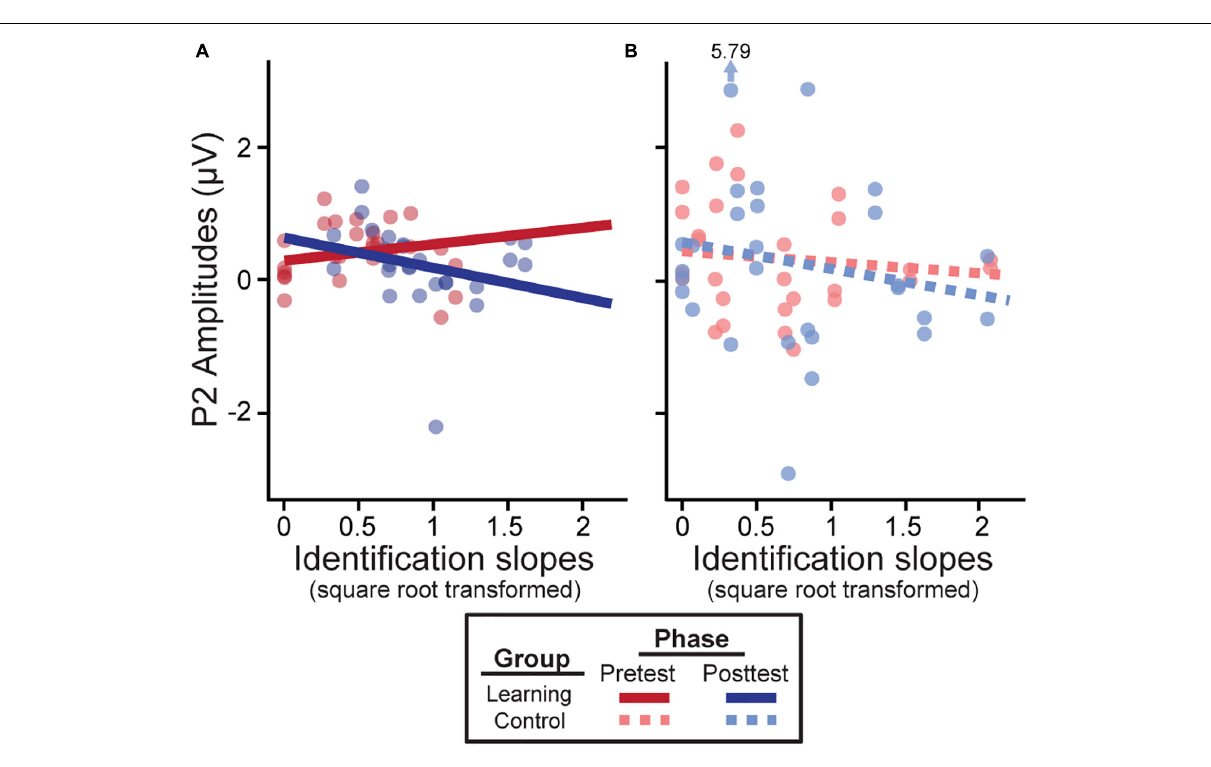
FIGURE 4 | Neural amplitudes scale with behavioral outcomes in the learning group (A) but not the control group (B) . Better posttest categorization (i.e., steeper identification slopes) is associated with a decrease in P2 amplitudes. Identification slopes were square-root transformed for statistical analysis. Data points indicate individual subjects (collapsed across tokens 1 & 5 and 3). Arrow/value mark an outlier (which did not alter